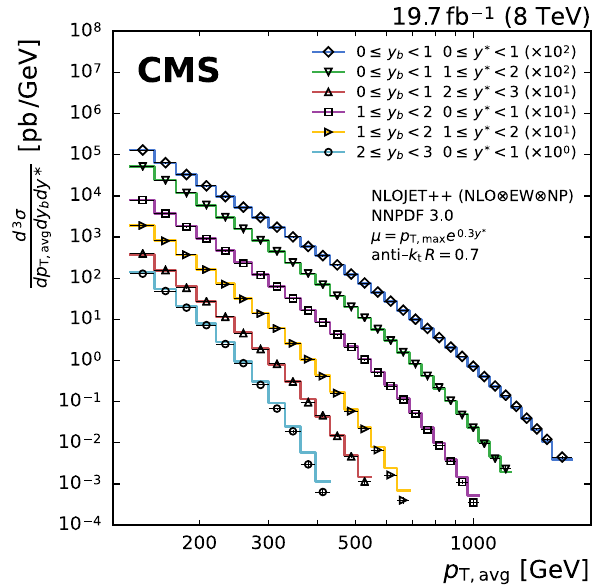
Fig. 6 Thetriple-differentialdijetcrosssectioninsixbinsof y ∗ and y b . The data are indicated by different markers for each bin. The theoretical predictions, obtained with NLOJet++ and NNPDF 3.0, and comple- mented with EW and NP corrections, are depicted by solid lines. Apart from the boosted region, the data are well described by the predictions at NLO accuracy over many orders of